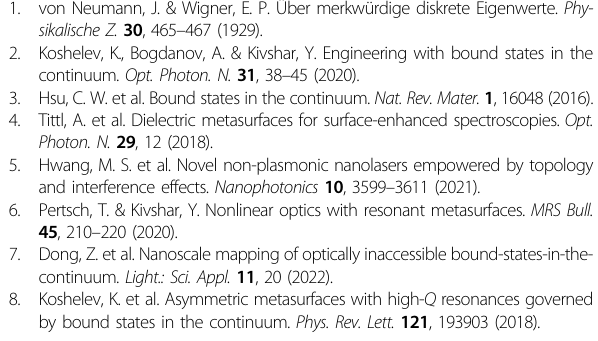
sounds, only the time will show what else can be found in the dark. Con fl ict of interest The authors declare no competing interests.